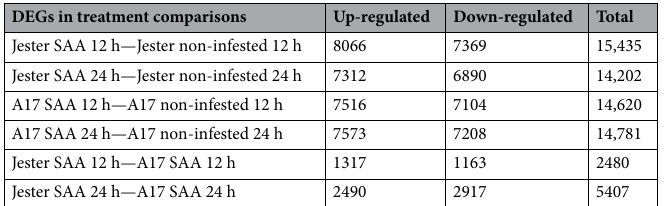
Table 2. Differentially expressed genes (DEGs) between resistant Jester and susceptible A17 M. truncatula varieties upon 12 and 24 h of SAA infestation.